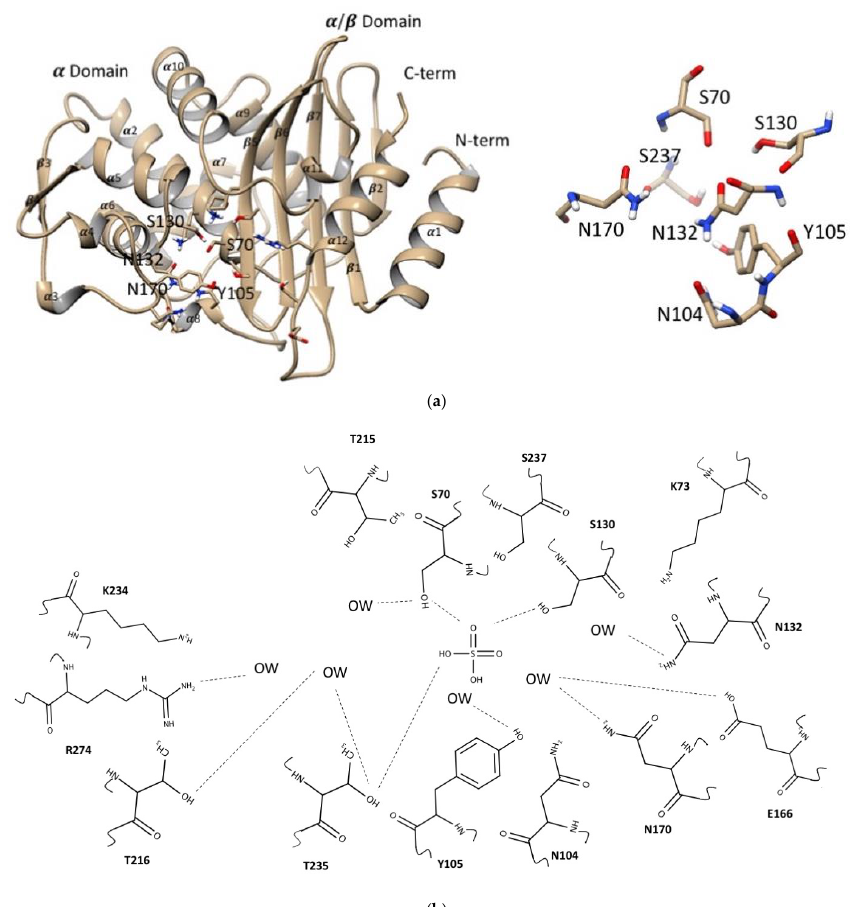
Figure 2. Global structure of CTX-M-15. ( a ) CTX-M-15 is shown with two domains, α and α / β . The active site is positioned toward the center, showing the catalytic Ser70, Lys73, Ser130, and Glu166. The figure was generated with UCSF Chimera v1.13.1. (San Francisco, CA, USA). ( b ) The 2D structure of binding pocket of CTX-M-15 contained the residues and water molecules was built by the MarvinSketch v.17.28.0. (Budapest,